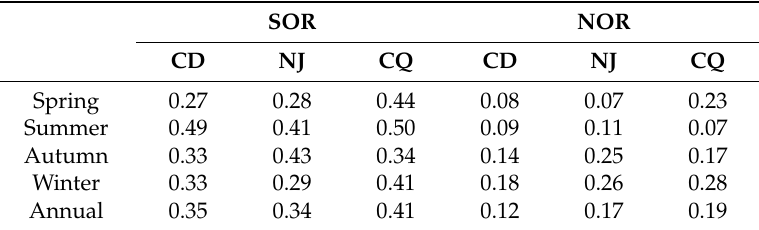
Table 3. Seasonal variation of sulfur oxidation ratio (SOR) and nitrogen oxidation ratio (NOR) in CD, NJ, and CQ. SOR NOR CD NJ CQ CD NJ